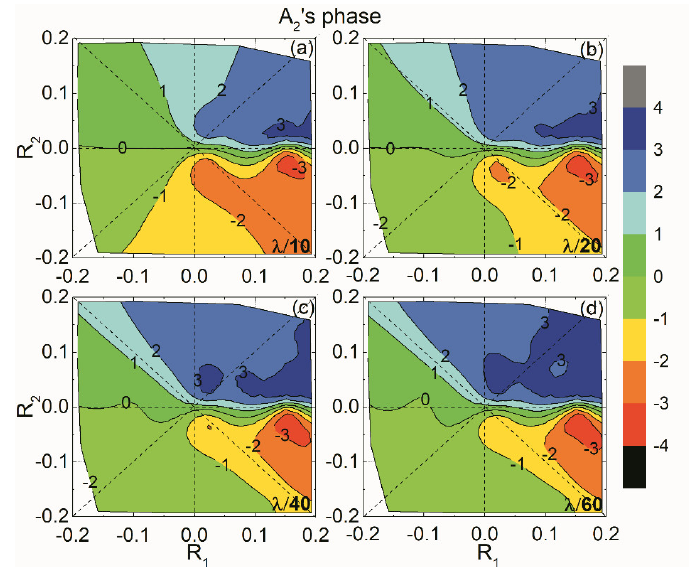
Figure 13. A 2 ’s phase of 120 thin-bed models with different thickness, R 1 or R 2 .